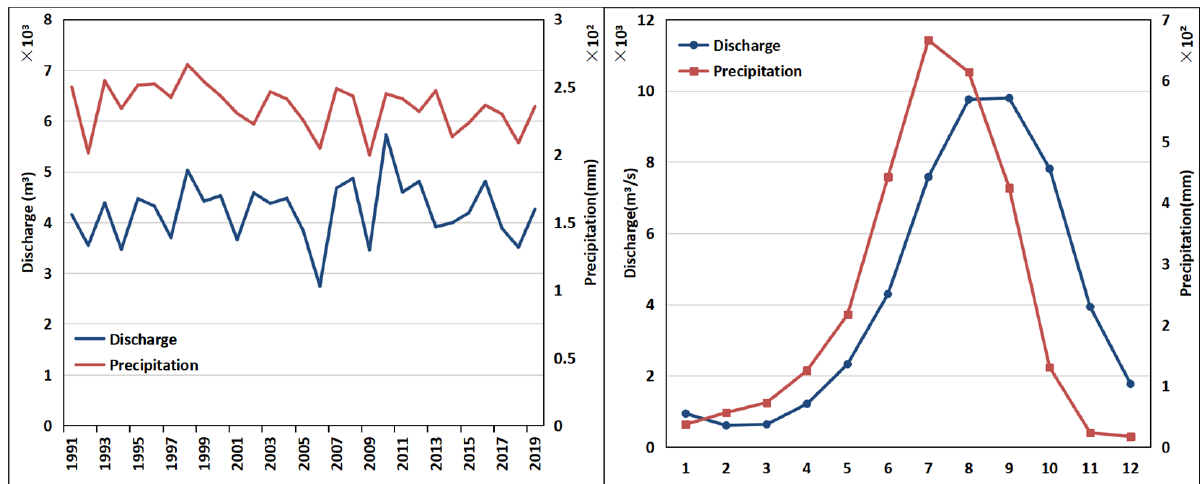
Figure 4. Changes of Padma River discharge and precipitation in the basin during the study period. The figures on the left and right show the average annual discharge and precipitation and the average monthly discharge and precipitation, respectively.